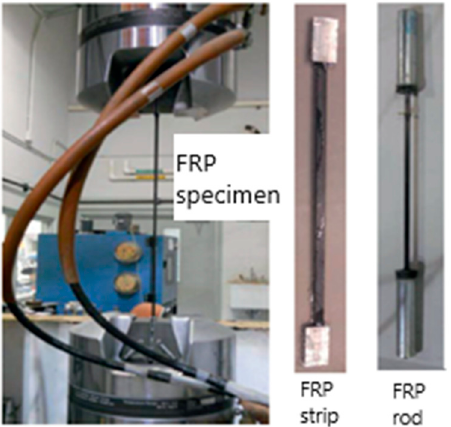
Figure 4. Test apparatus and FRP composite specimen placement for room temperature strength test.